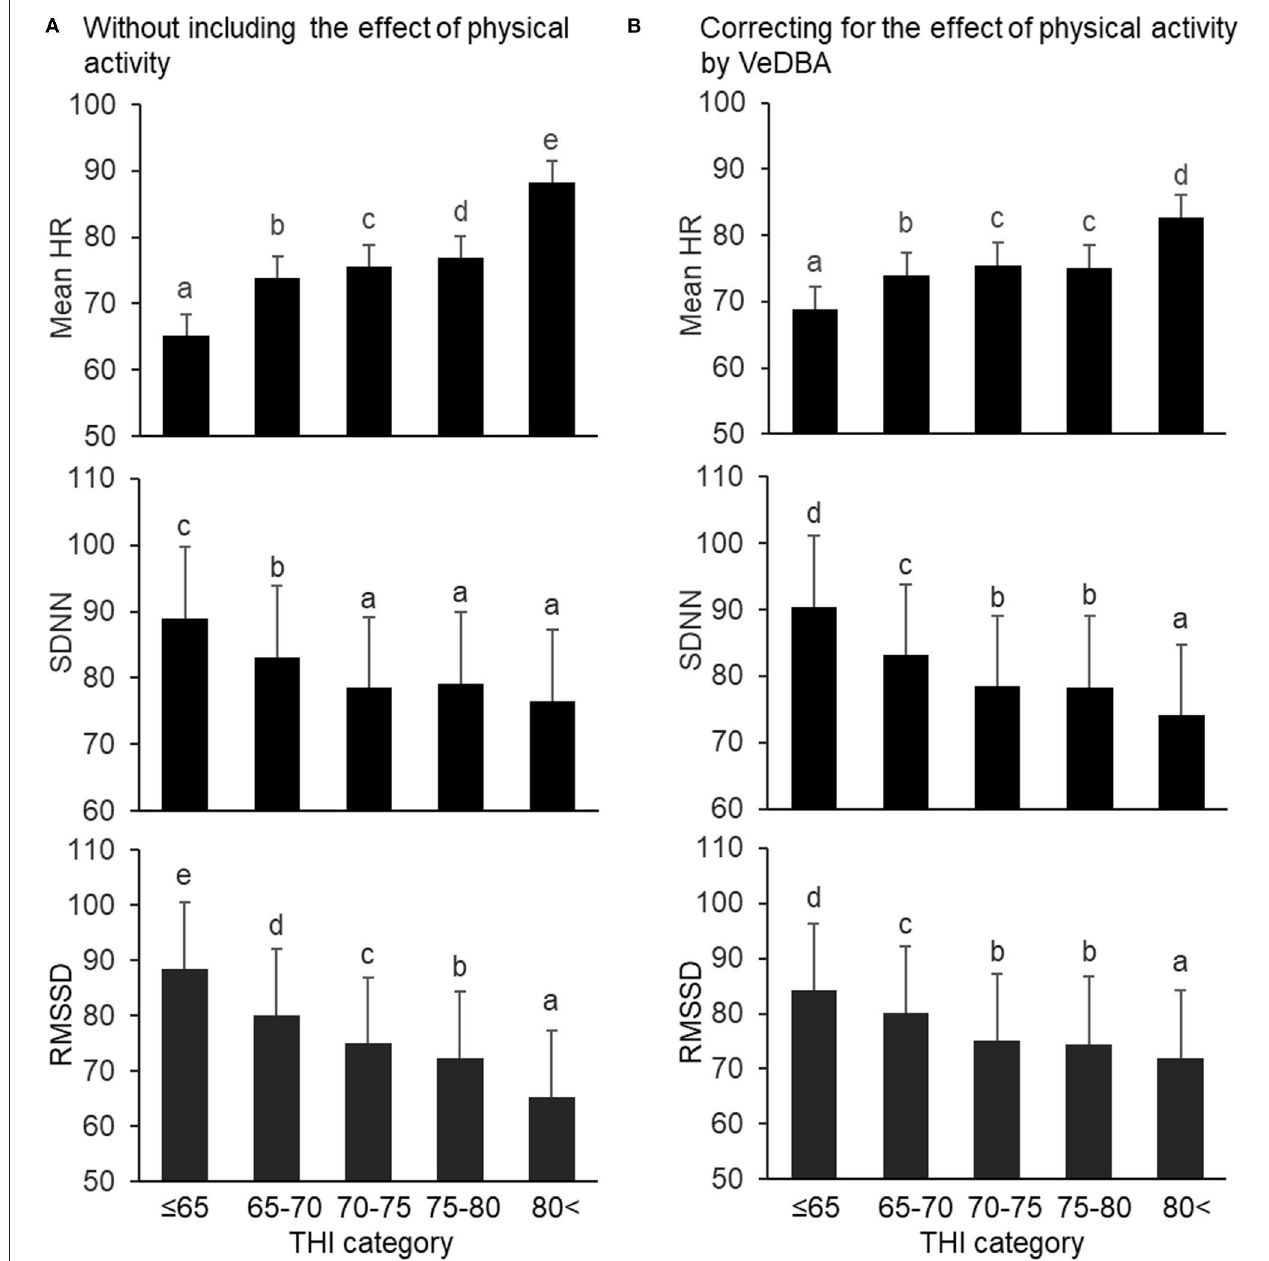
FIGURE 2 | Changes in mean HR and time domain HRV parameters (SDNN and RMSSD) by THI category, (A) without and (B) with the effect of physical activity quantified by VeDBA. The bars represent least square means, and error bars show standard errors. Values with different letters differ significantly ( P < 0.05). HR, heart rate (bpm); HRV, heart rate variability; SDNN, standard deviation of inter-beat intervals (ms); RMSSD, square root of the mean squared differences of successive inter-beat intervals (ms); THI, temperature–humidity index; VeDBA, natural logarithmically transformed vectorial dynamic body acceleration